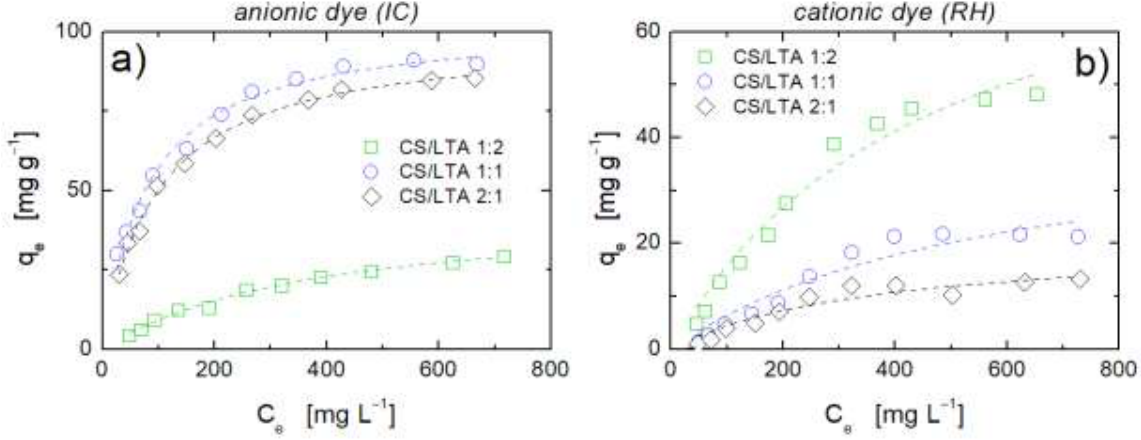
Figure 7. Adsorption isotherms at 25 °C of ( a ) anionic dye IC and ( b ) cationic dye RH for hybrid aerogels at different CS/LTA weight ratios: 1:2 (squares), 1:1 (circles), and 2:1 (diamonds). Dashed lines represent best fitting with the Langmuir model (Equation (2)).